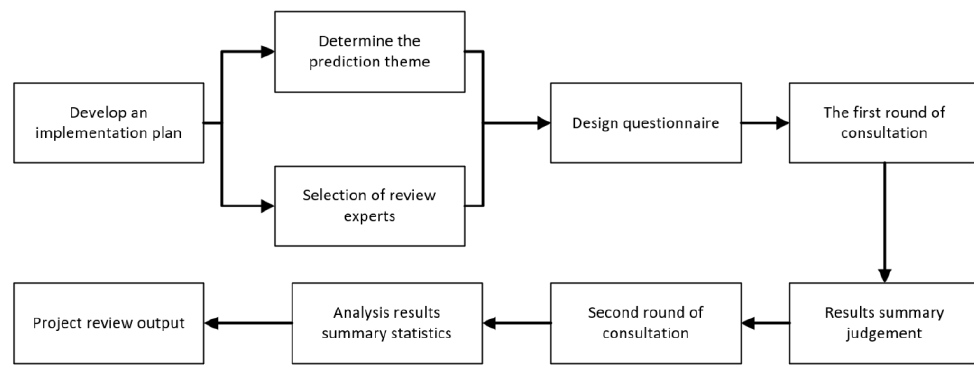
Figure 2. The flowchart of the Delphi method.